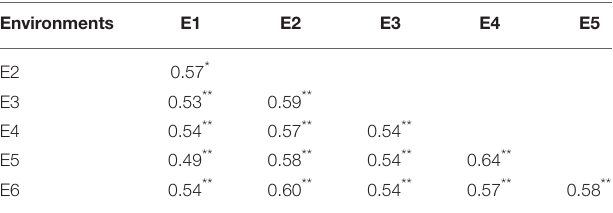
TABLE 3 | Correlation analysis of branch angle between environments.